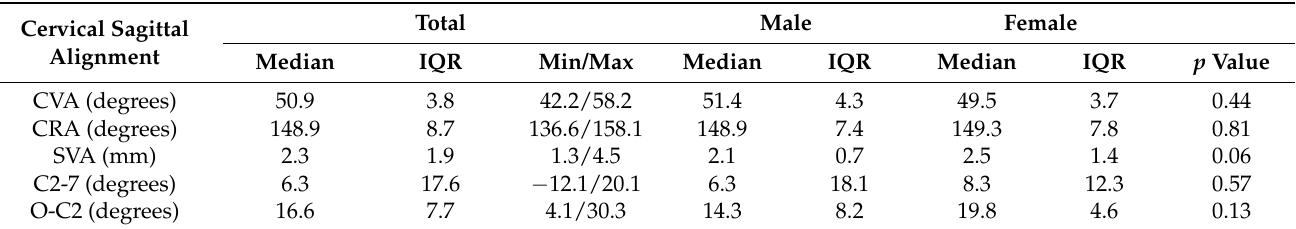
Table 2. Sex differences for each value ( n = 26).